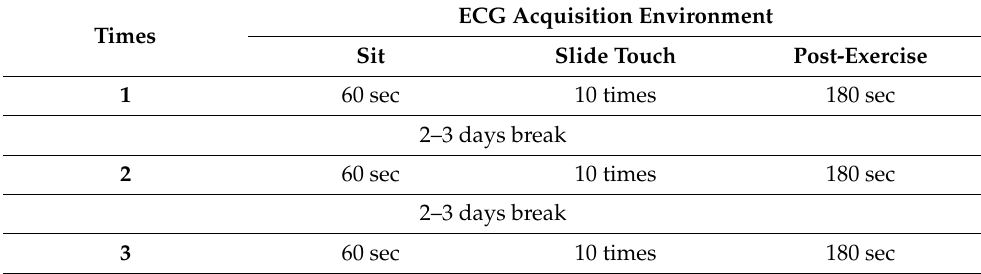
Table 4. ECG acquisition protocol considering the driving